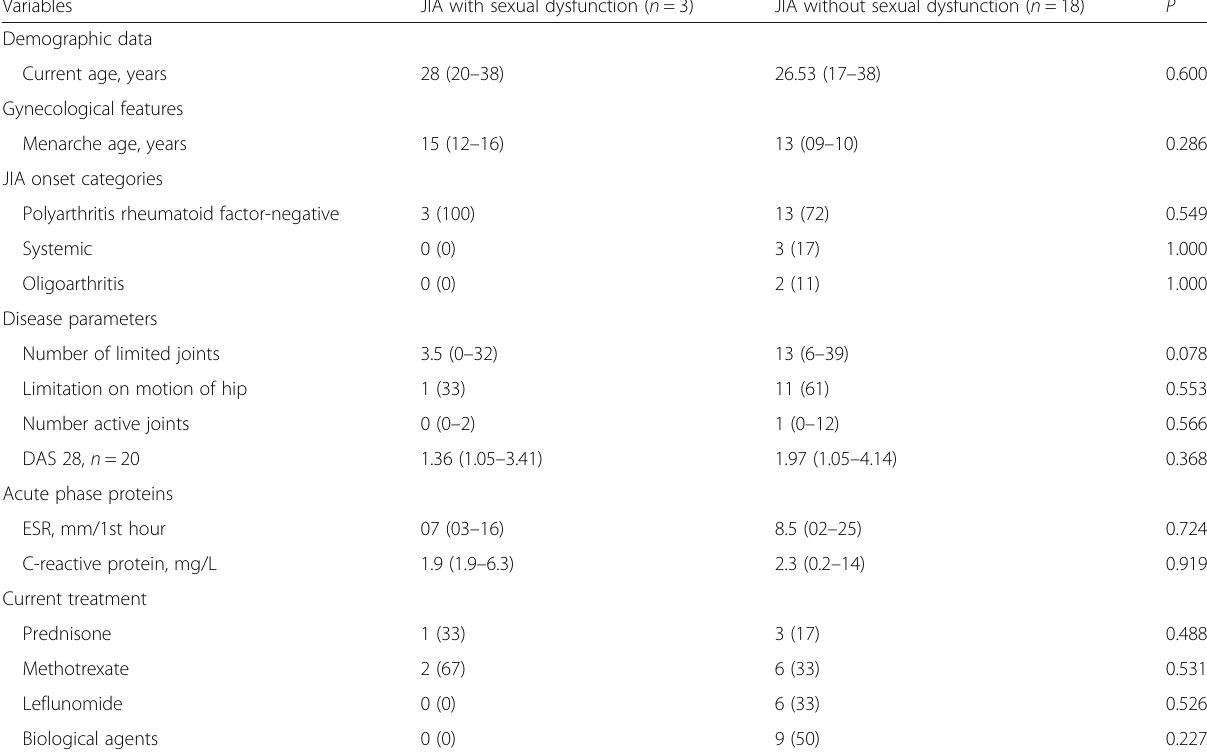
Table 3 Demographic data, gynecological features, disease parameters and acute phase proteins in juvenile idiopathic arthritis (JIA) patients with and without sexual dysfunction (SQQ-F score < 62)